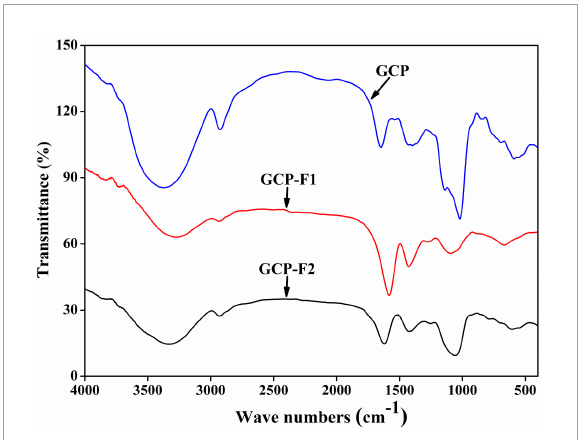
FIGURE2 Fourier transform infrared (FT-IR) spectra of Genistein Combined Polysaccharide (GCP), GCP-F1, and